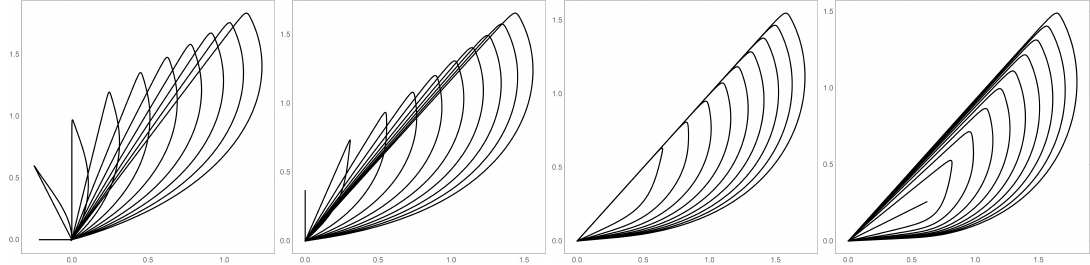
Figure 4. Parametric curves, P ( 3 ) ( ρ ; p ) from Equation (12), of f N ( z ) for four different values of k read left-to-right, top-to-bottom: k = 1, k = 2, k = 4, k = 8. Shown are the first 10 values of p . The case of p = 1 has no interior points and is directed at an angle equal to α 1 in R 2 . Increasing values of p lead to closed curves which are bigger and have greater interior area. As ρ goes from 0 to 1 the curve is traversed in a counterclockwise